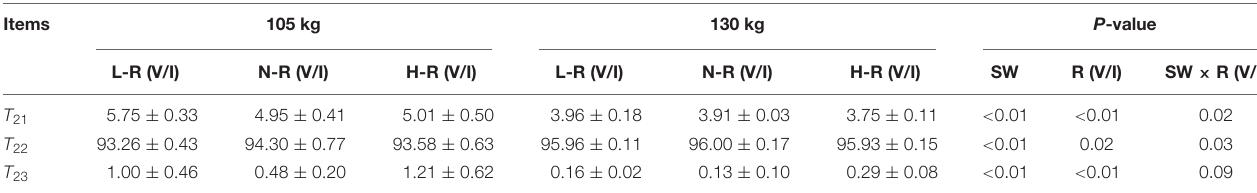
TABLE 4 | Effect of dietary R (V/I) and slaughter weight on the T 2 peak area ratio of longissimus dorsi in finishing pigs ( n =